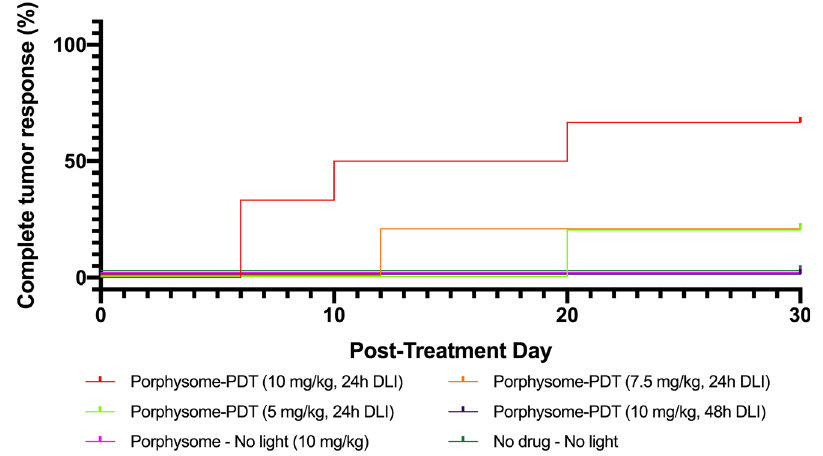
Figure 4: Complete tumor responses for treatment and control